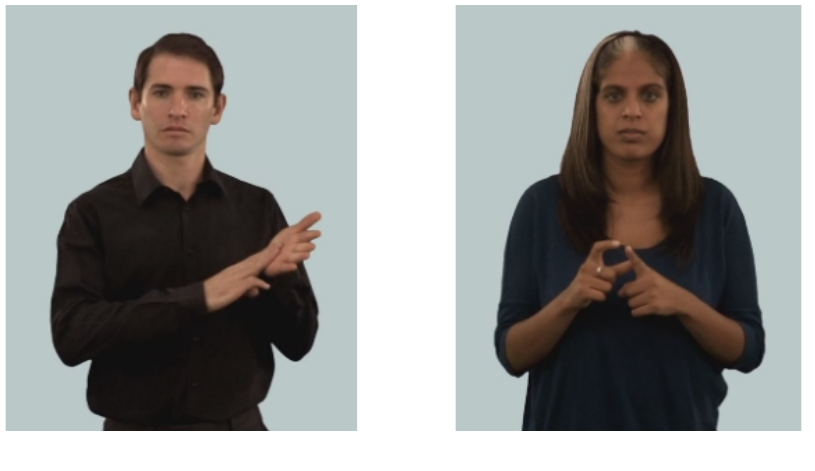
Figure 3 : BSL mother and